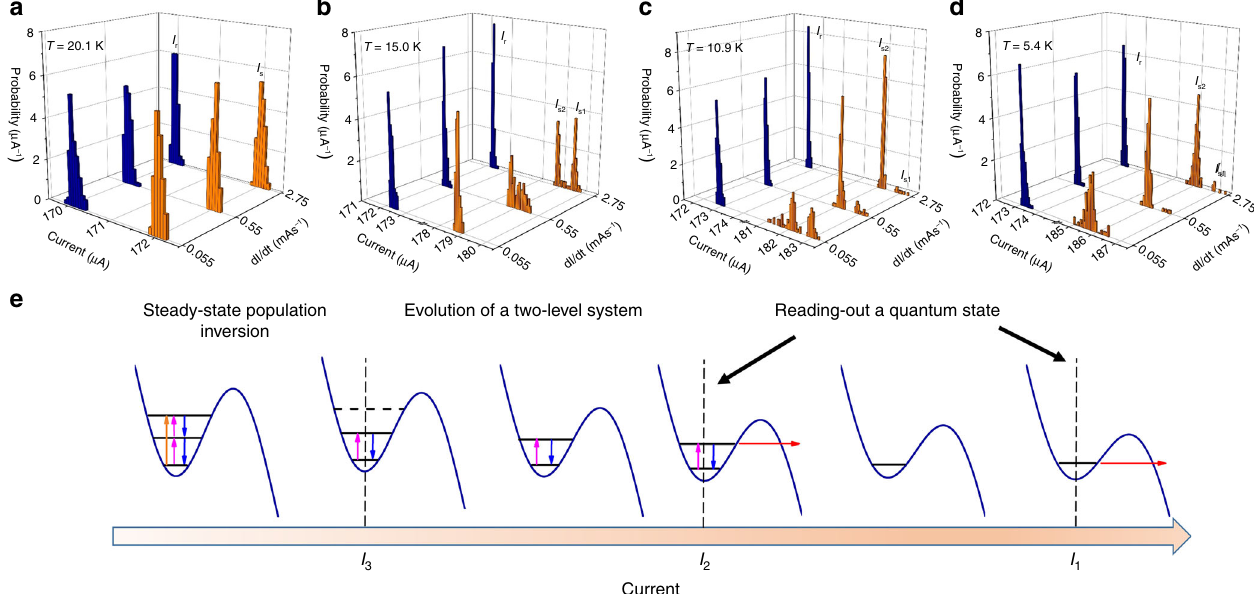
Fig. 4 Switching-current measurements for the nanowire under illumination with 77 K BBR. a – d Switching- (orange) and retrapping-current (blue) distributions for a 55-nm-wide YBCO nanowire at different temperatures. Source data are provided as a Source Data fi le. e Energy levels in the local minimum of the tilted washboard potential at different bias currents for the nanowire illuminated using 77 K black body radiation. Transitions between energy levels are shown using orange, magenta, and blue arrows. Escape in the resistive state by tunneling is indicated by red